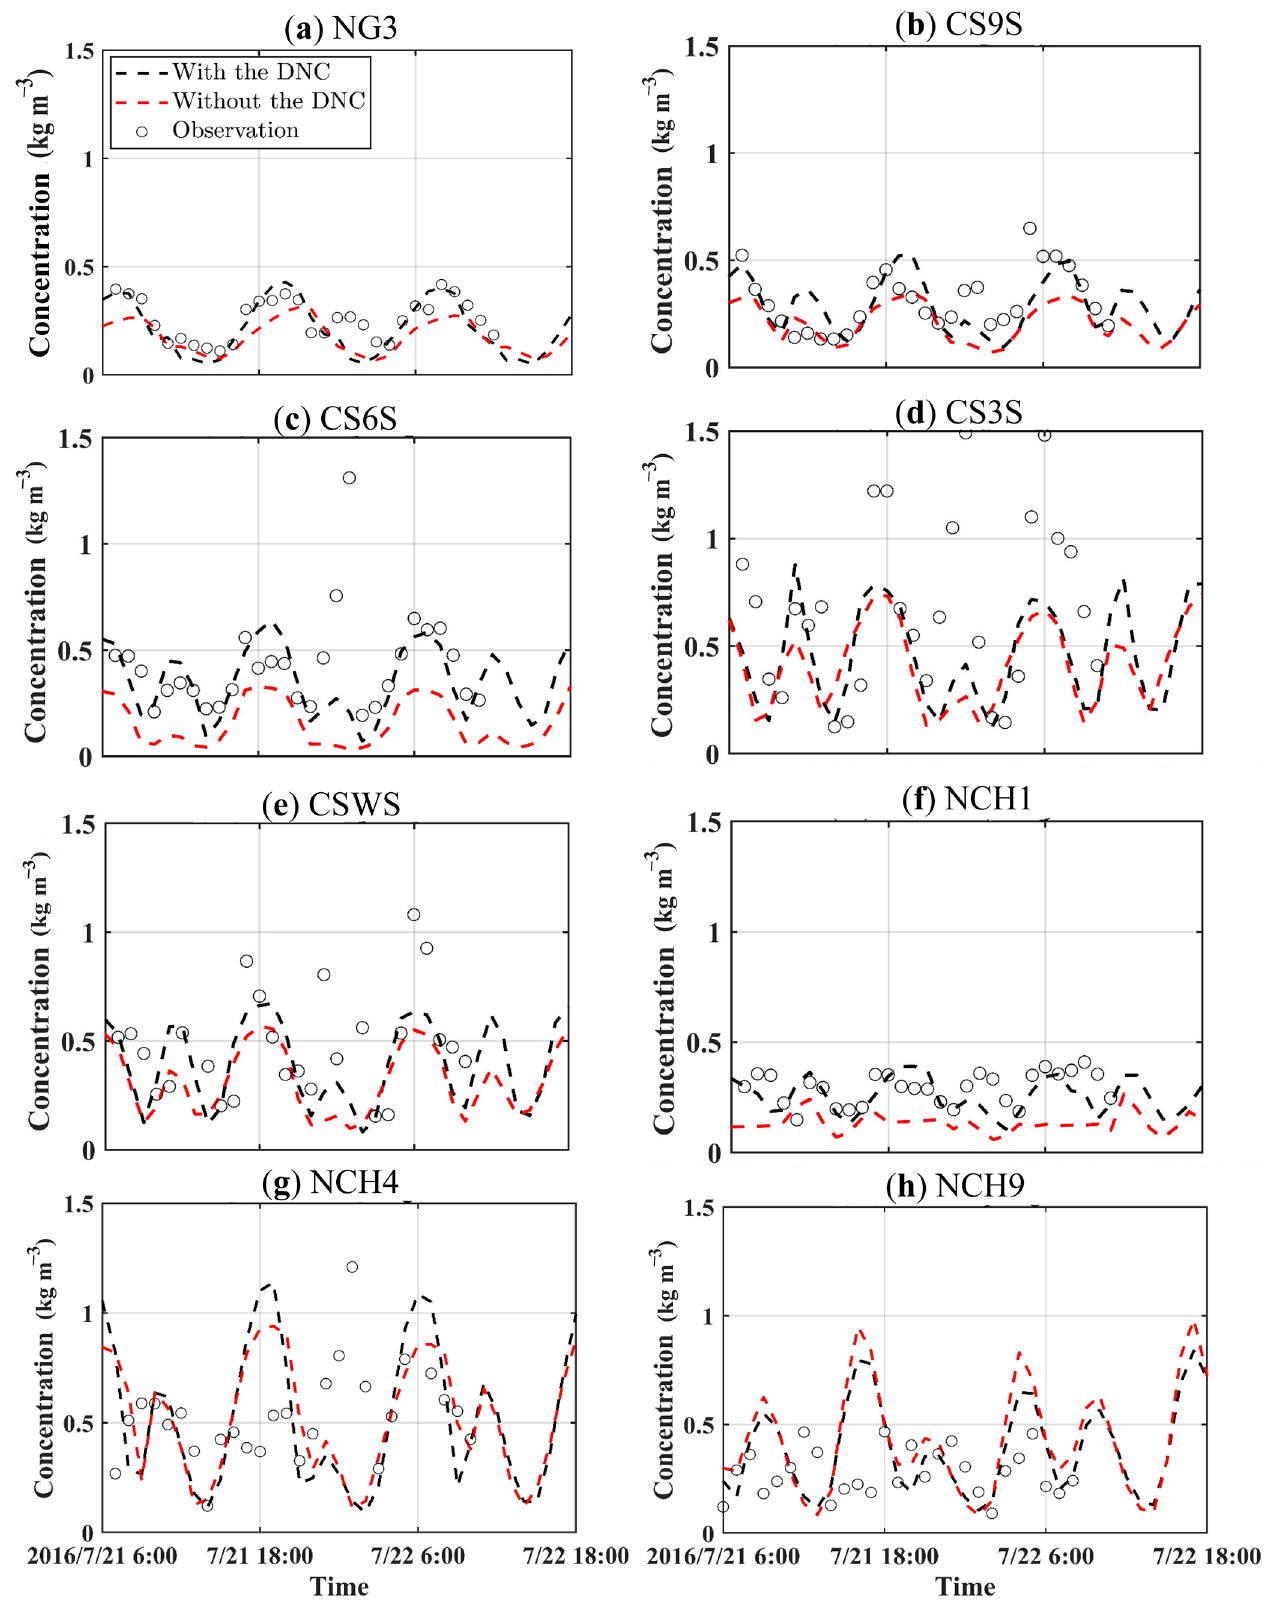
Figure 11. Comparison of simulated and measured SSC during spring tide under the influence of Deepwater Navigation Channel (DNC), and subfigures ( a – h ) represent the comparison results at 8 stations for SSC shown in Figure 3b, respec- tively.